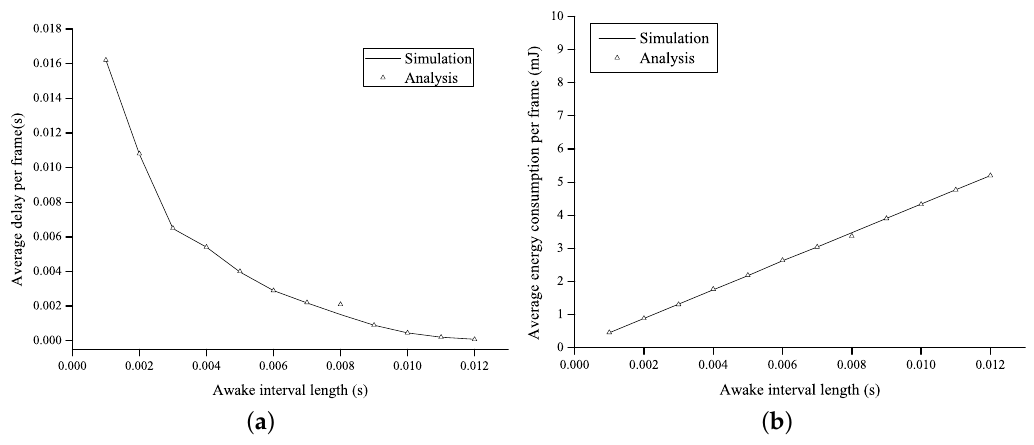
Figure 7. Performance of the NoA method. ( a ) average delay per frame; and ( b ) average energy consumption per frame.